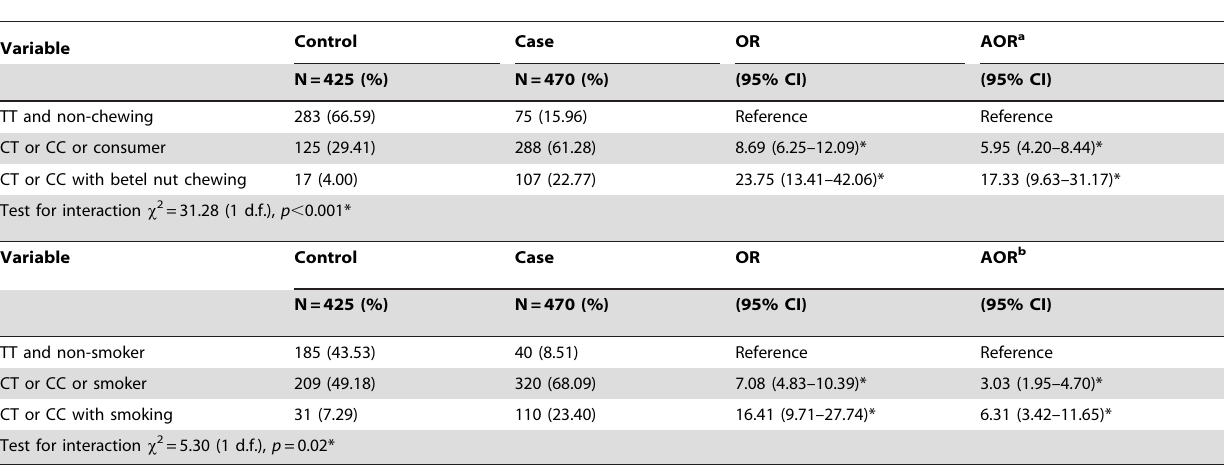
Table 3. Association of miRNA 499 genotype and betel nut chewing and smoking status.